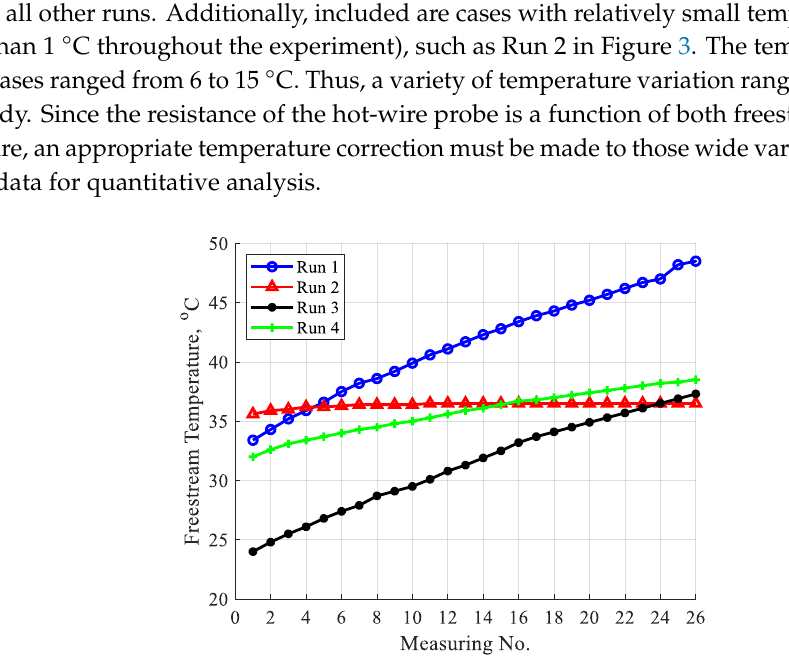
Figure 3. Freestream temperature variation plotted against measuring number at different heights from the wall during wind tunnel operation for four different runs.